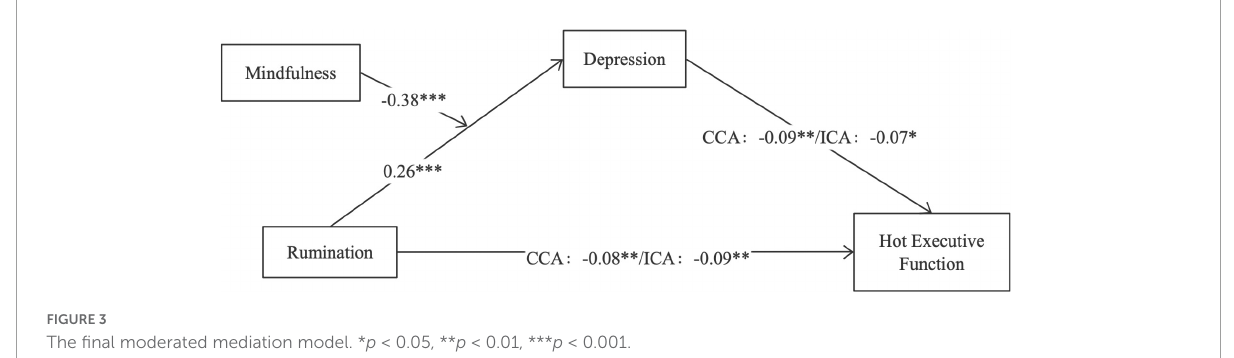
FIGURE3 The final moderated mediation model. * p < 0.05, ** p < 0.01, *** p <